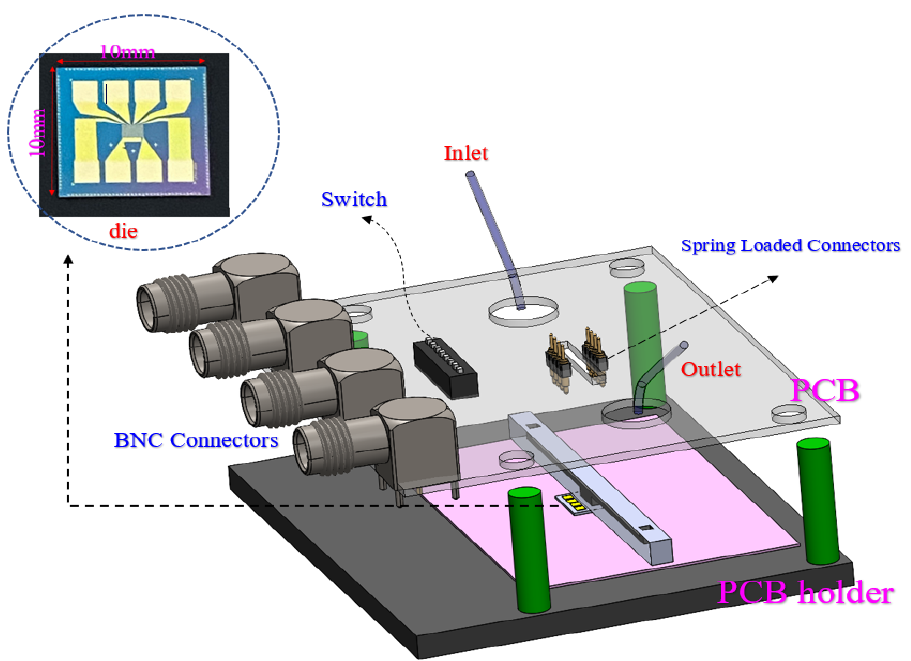
Figure 3. The electrical packaging technique. Spring-loaded connector was used to connect the sensor pads to a switch. The switch is connected to BNC connector.